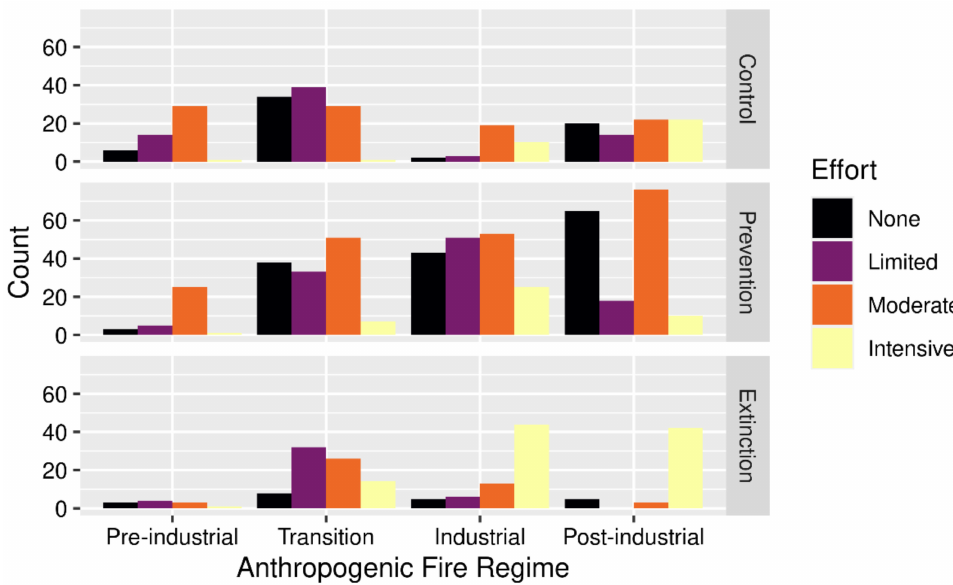
Figure 4. Fire Suppression by Anthropogenic Fire Regime. Counts are of case studies including a given fire suppression action. Effort levels are described in Section